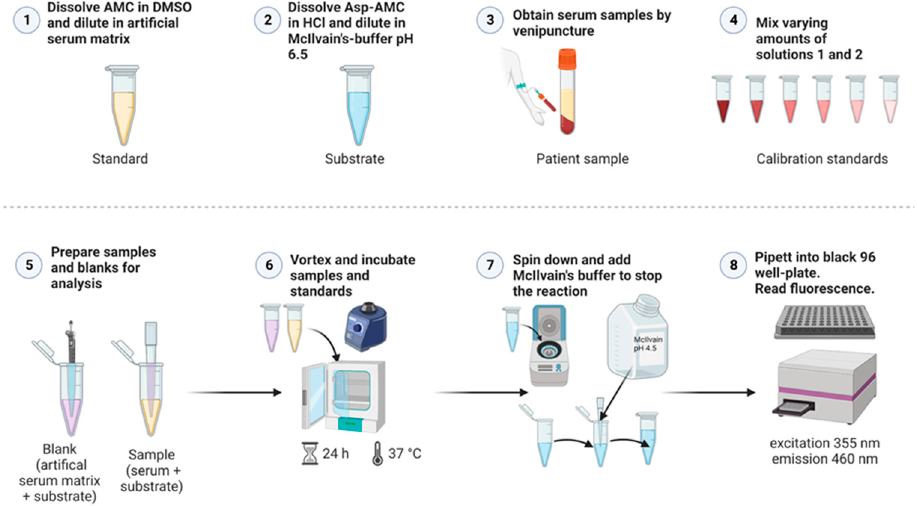
Figure 6. Schematic presentation of the steps of the AGA activity assay. See Section 4.4 for details.